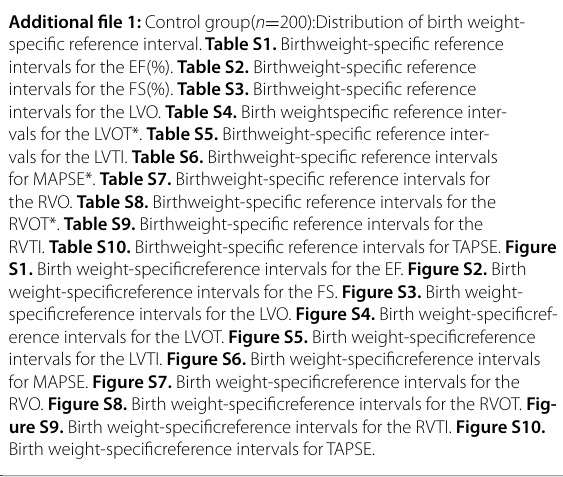
erence intervals for the LVOT. Figure S5. Birth weight‑specificreference intervals for the LVTI. Figure S6. Birth weight‑specificreference intervals for MAPSE. Figure S7. Birth weight‑specificreference intervals for the RVO. Figure S8. Birth weight‑specificreference intervals for the RVOT. Fig- ure S9. Birth weight‑specificreference intervals for the RVTI. Figure S10. Birth weight‑specificreference intervals for